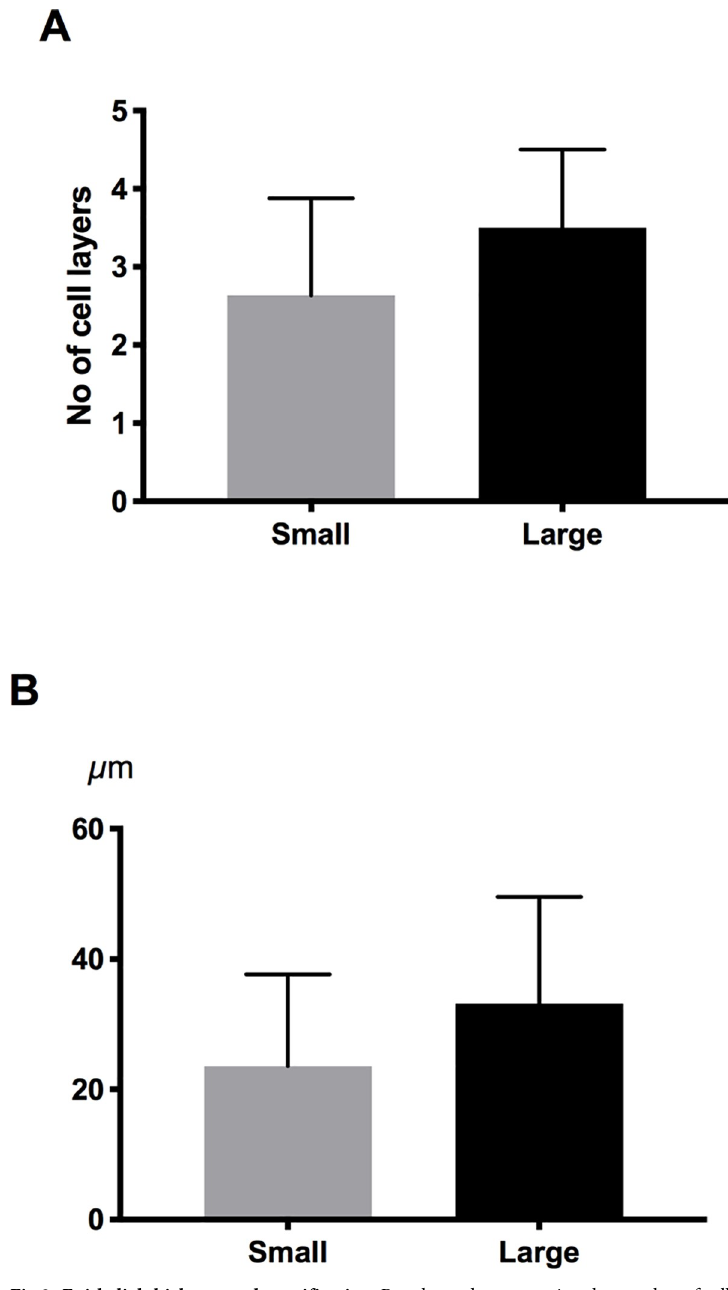
Fig 2. Epithelial thickness and stratification. Bar charts demonstrating the number of cell layers (A) and epithelial thickness (B) measured in LEC cultures derived from small and large explants. There were no significant differences between the groups. Error bars represent the standard deviation of mean